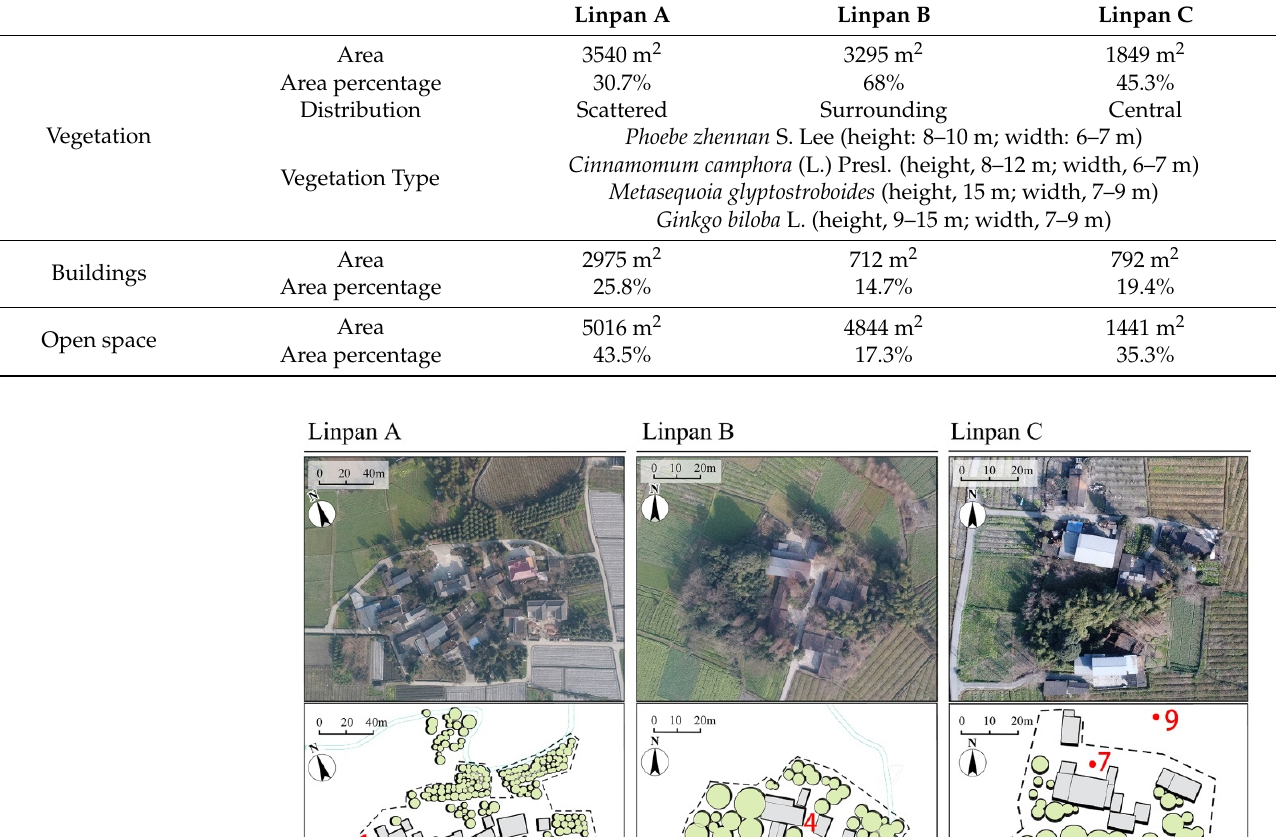
Table 2. The composition of Linpan A, B, and C.